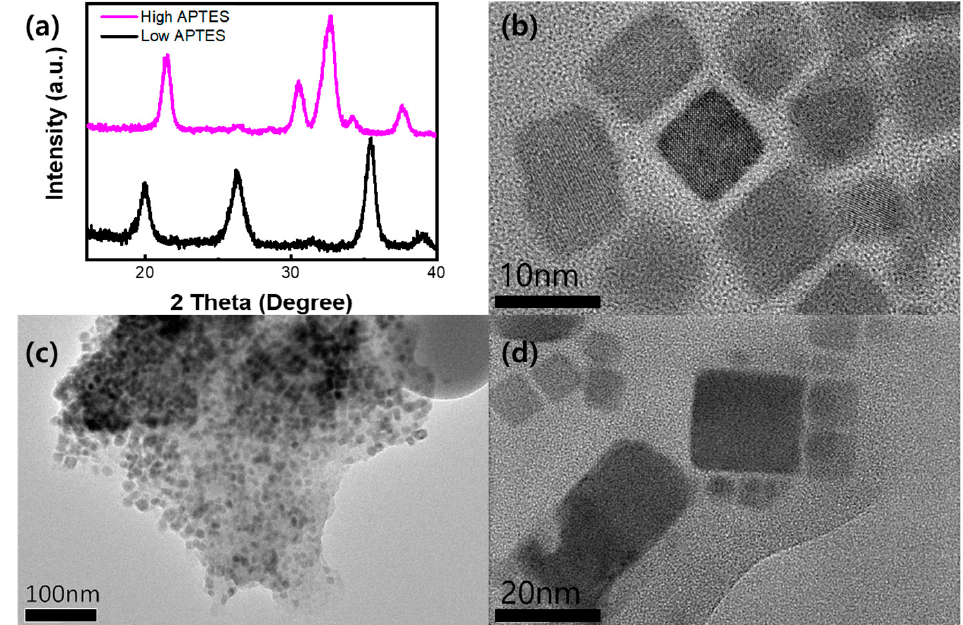
Figure 1. ( a ) XRD pattern for core-shell perovskite/SiO 2 NCs with low and high amount of APTES. ( b , c ) TEM image of core-shell perovskite/SiO 2 NCs synthesized with ( b ) low and ( c ) high amount of APTES. ( d ) High magnitude TEM image for core-shell perovskite/SiO 2 NCs with high amount of APTES.